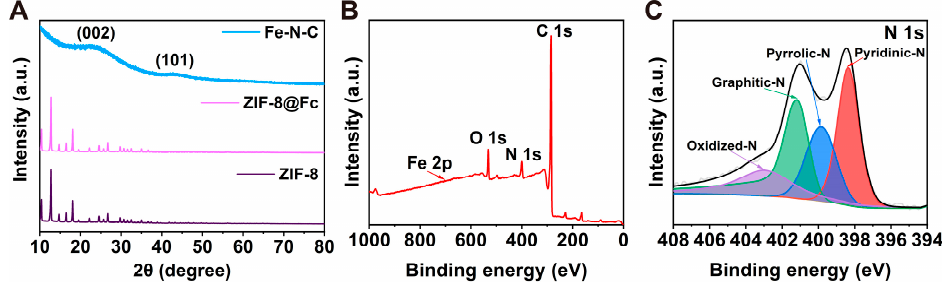
Figure 2. ( A ) XRD patterns of Fe-N-C, ZIF-8@Fc, and ZIF-8. ( B ) XPS survey spectrum of Fe-N-C. ( C ) XPS spectrum of N 1s for Fe-N-C.